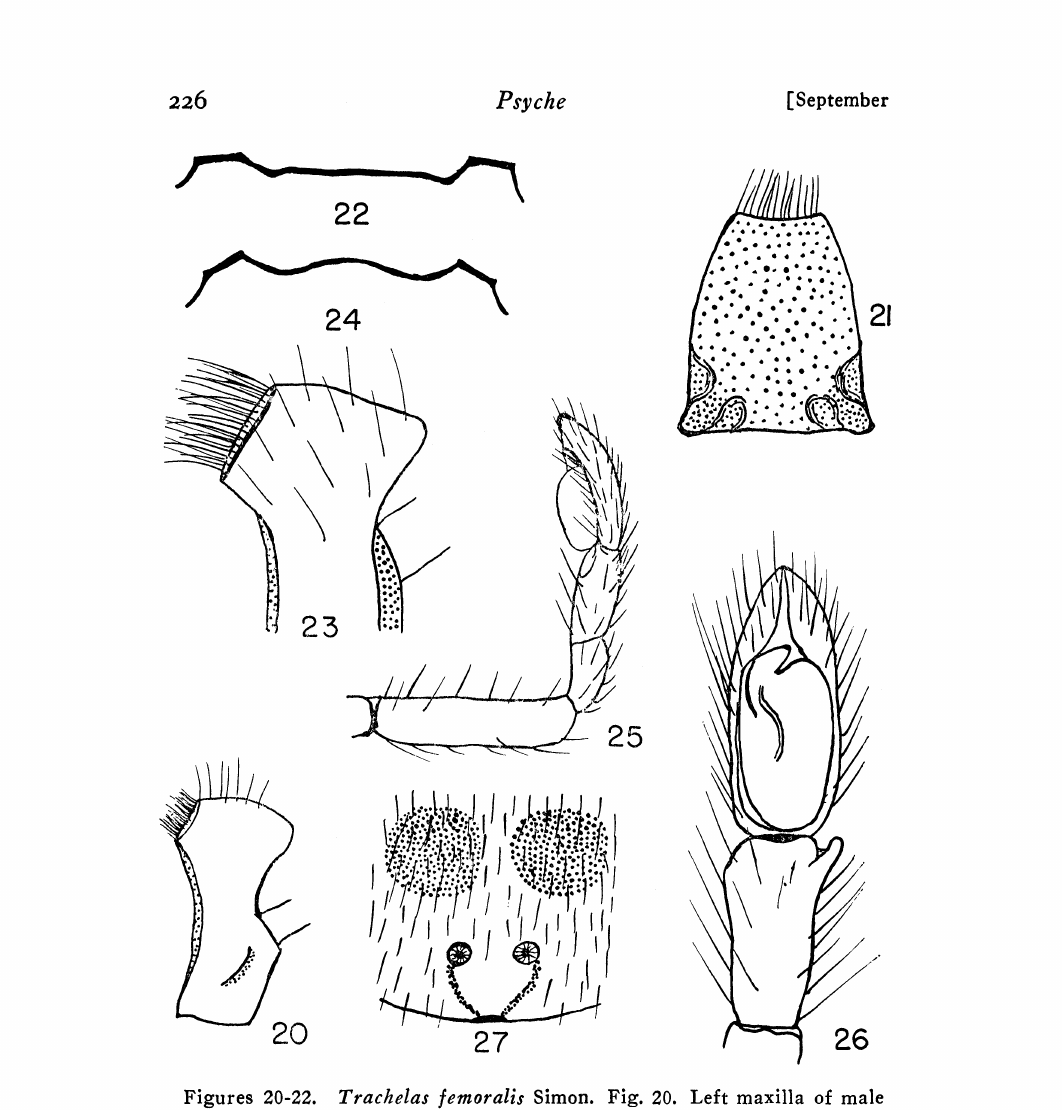
Figures 20=22. Trachelas feraoralis Simon. Fig. 20. Left maxilla of male from below. Fig. 21. Lip of male from below. Fig. 22. Anterior border of sternum of male from below. Figures 23-27. Trachelas mulcetus sp. nov. Fig. 23. Left maxilla of holotype from below. Fig. 24. Anterior border of sternum of holotype from below. Fig. 25. Left palp of holotype; retro- lateral view. Fig. 26. Left palpal tibia and tarsus of holotype; nearly ventral view; more enlarged. Fig. 27. Epigynum of described female paratype from